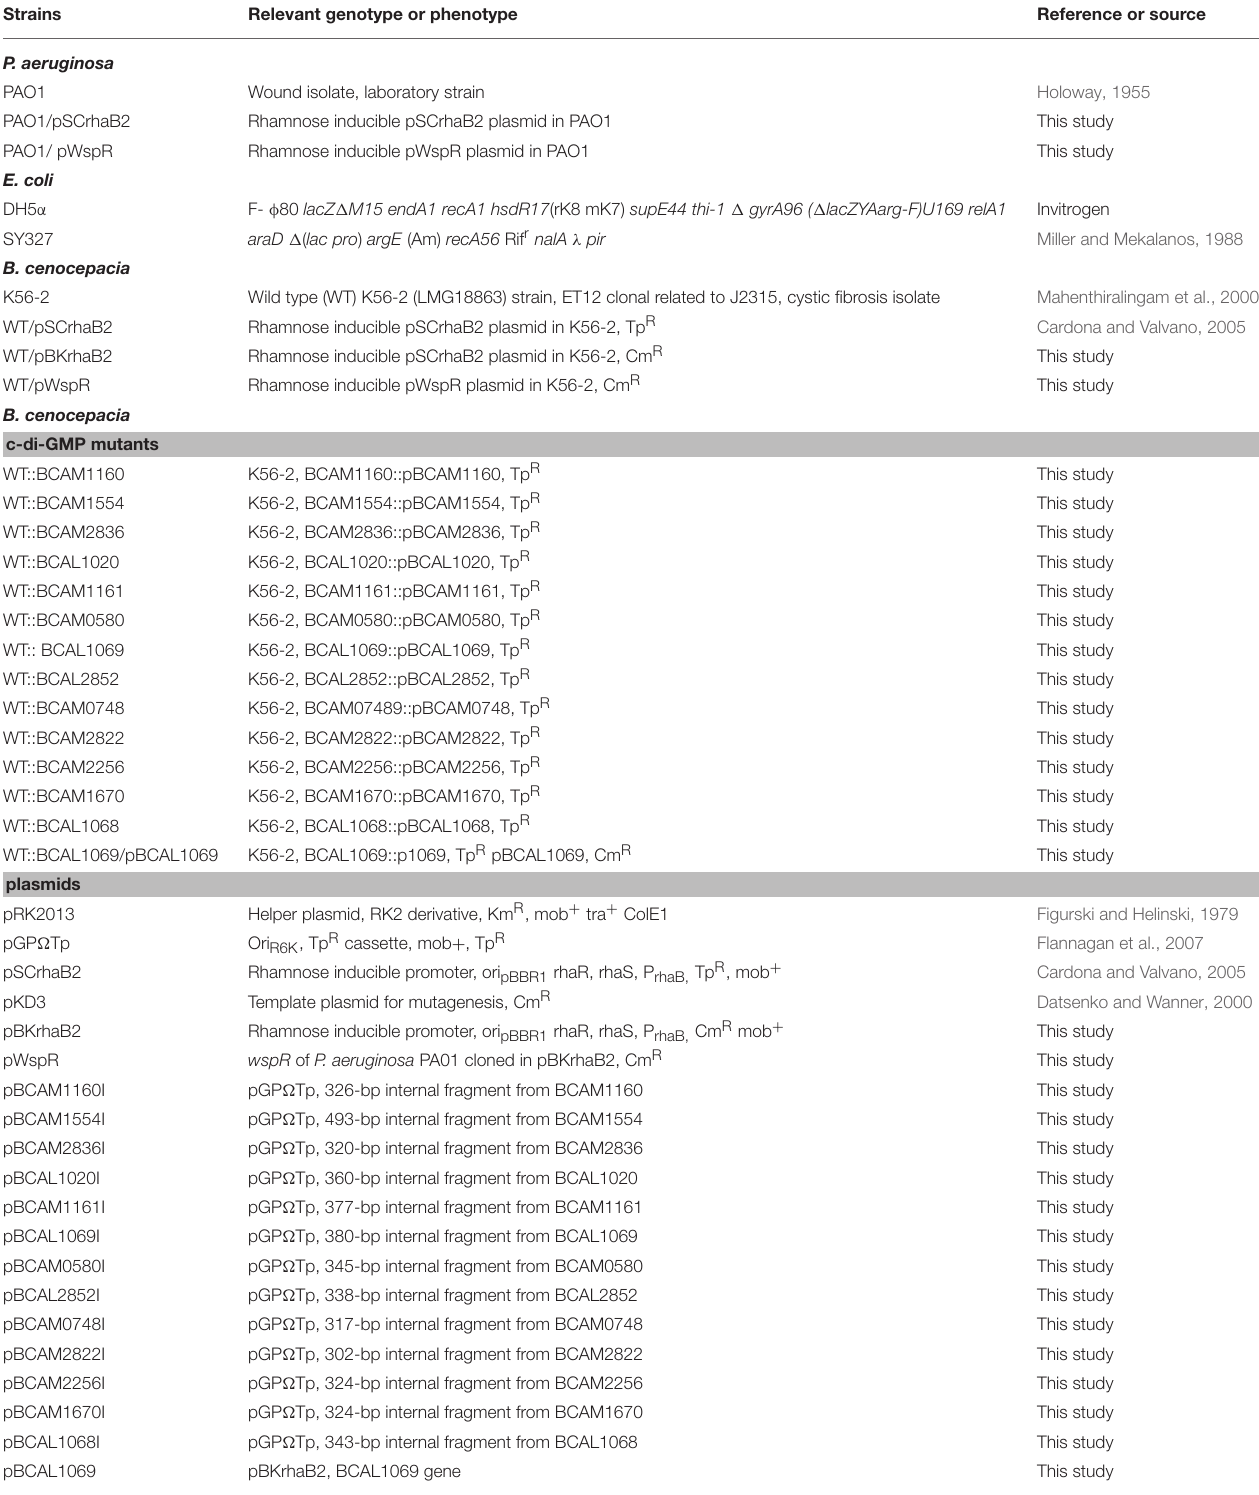
TABLE 1 | Strains and plasmids used in this